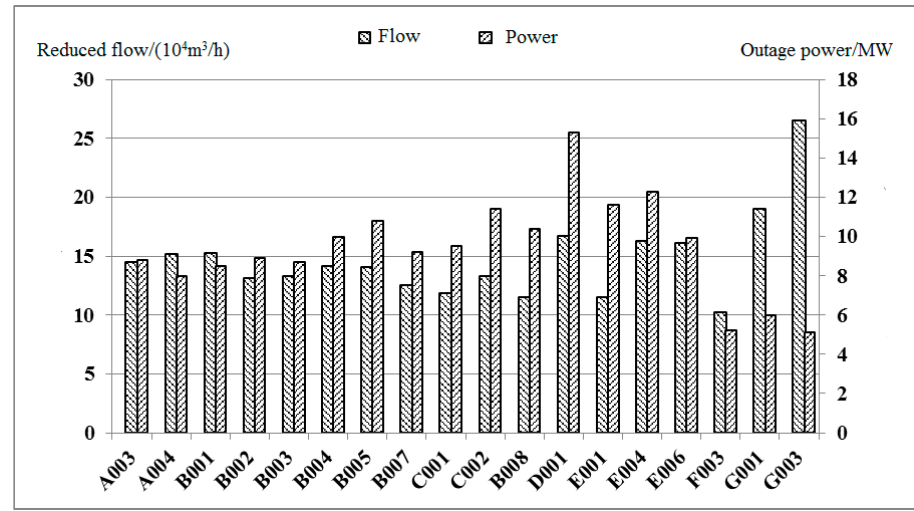
Figure 5. Influence of different faulted compressor positions on flow and power.